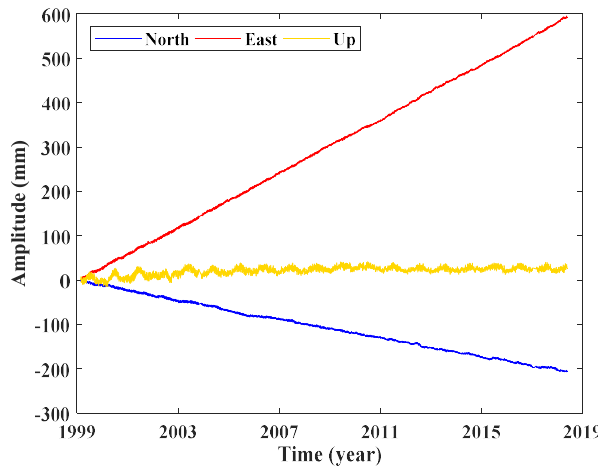
Figure 4. Position time series of BJFS station.